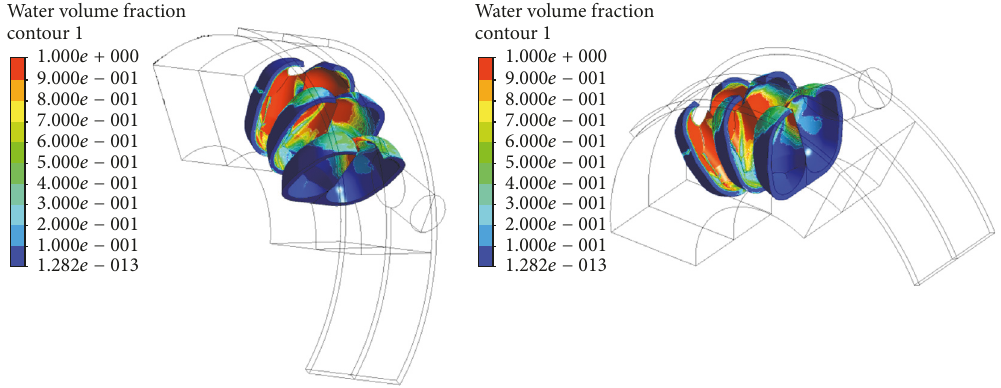
Figure 14: Volume fraction of water for reference bucket design at a particular time step (PCD = 400 mm).